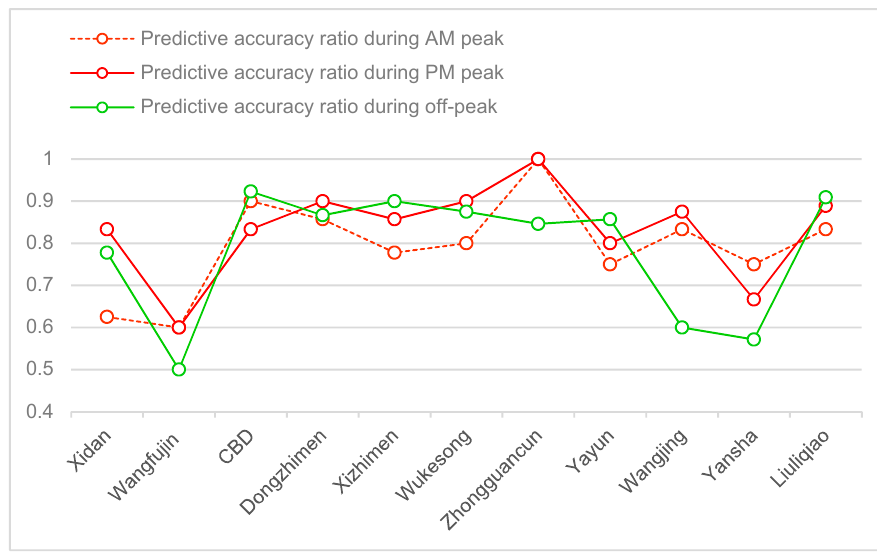
Figure 5. Predictive accuracy ratio between peak and off-peak times. 385